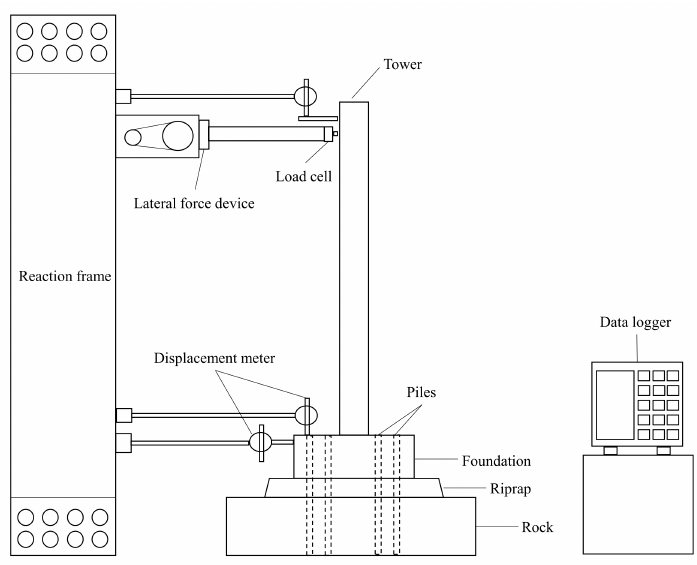
Figure 6. Layout of model experiment apparatus.